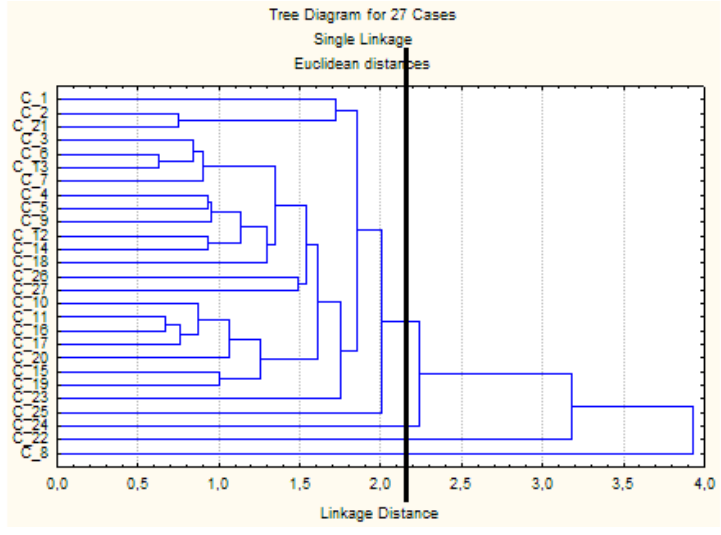
Fig. 8: Definition of a representative district for each rural area cluster in the Vinnytsia region SymbolsforruralareasoftheVinnitsaregion: Barskiy С_1; Bershadskiy С_2; Vinnitsa С_3; Gaisinskiy С_4; Zhmerinskiy С_5; Illinetskiy С_6; Kalinovskiy С_7; Kazatinskiy С_8; Kryzhopolskiy С_9; Lipovetskiy С_10; Litinskiy С_11; Mogilev-Podolskiy С_12; Murovanokurilovetskiy С_13; Nemirovskiy С_14; OratowskiC_15; PesczanskiC_16; PogrebishcheskiC_17; TepliceC_18; TyrowskiC_19; TomaspolskiC_20; TrostyanetskiC_21; TulchinskiC_22; KhmelnitskiC_23; ChernowitskiC_24; ChechelnitskiC_25; ShargorodskiC_26; YampolskiC_27